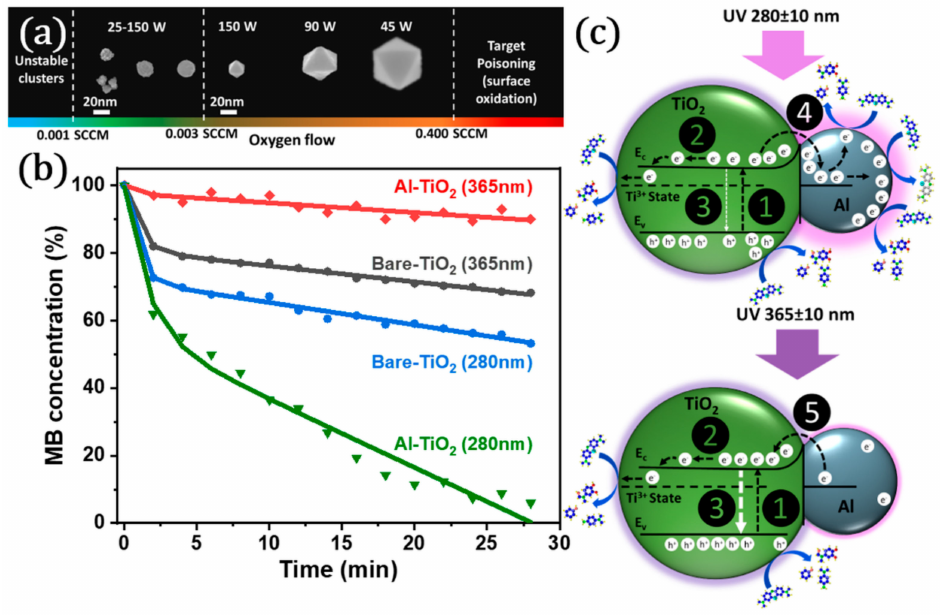
Figure 11. ( a ) Schematic representation of the gas aggregation source (GAS) used to produce Al NPs. ( b ) Photocatalytic degradation of MB solution at 365 ± 10 nm and 280 ± 10 nm UV irradiation by Al-TiO 2 hybrid structures and ( c ) main mechanisms observed in photocatalytic degradation of MB by Al NPs decorated TiO 2 thin film at 280 ± 10 and 365 ± 10 nm, where colored purple around Al NPs represent the localized surface plasmon resonance (LSPR). (1) Electron-hole generation. (2) Reduction of Ti 4 + cations to the Ti 3 + state. (3) Recombination. (4) Trapping of electrons by Al NPs. (5) Injection of electrons by Al NPs. ((4) and (5) coexist, but depending on the corresponding wavelength, one of them dominates.) Adapted with permission from [31]. Copyright (2018) American Chemical